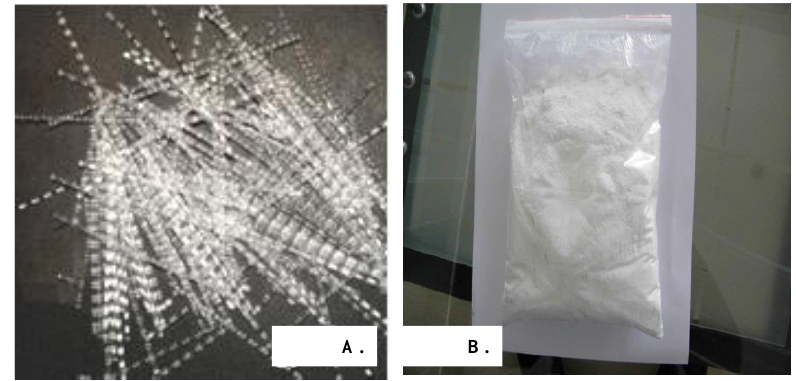
Fig. 2. A. Nylon fibers. B.